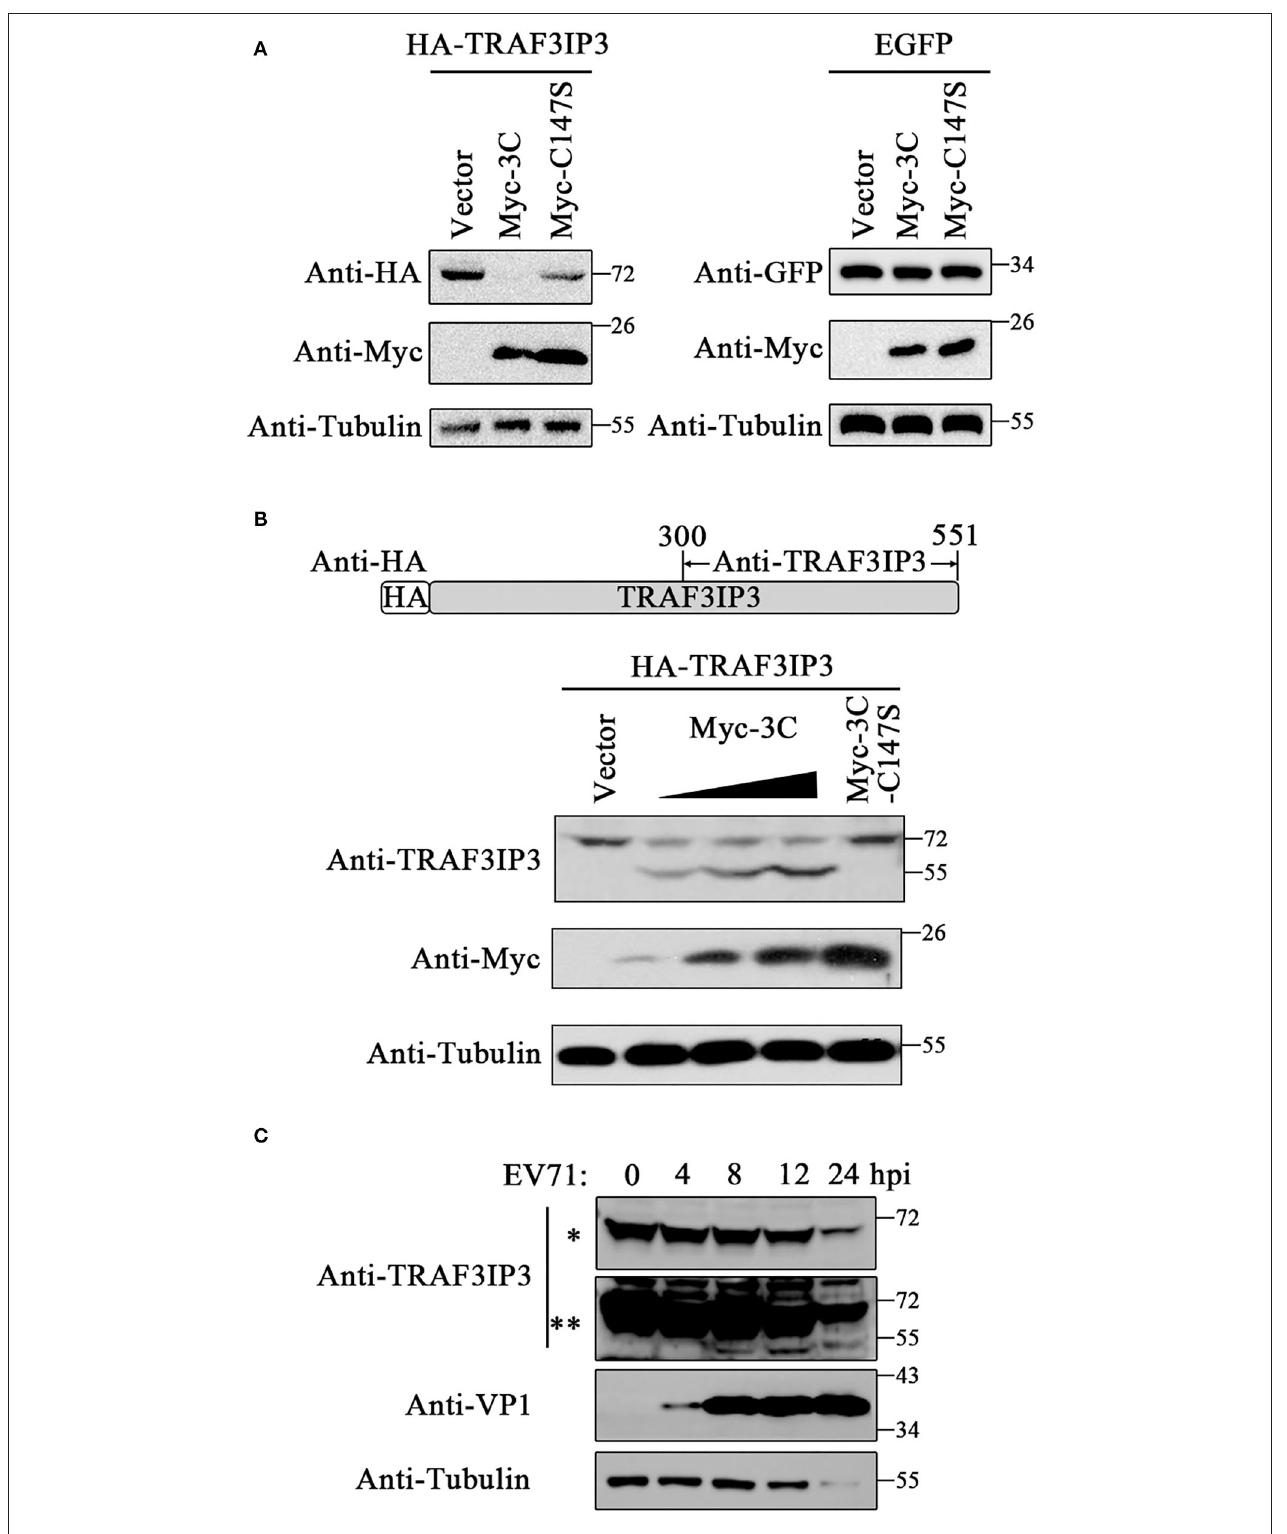
FIGURE 2 | TRAF3IP3 is the cleavage substrate for 3C pro . (A) HA-TRAF3IP3 or GFP was co-transfected with 3C pro or C147S into HEK293T cells. Cells were harvested 48h later for Western blotting. (B) HEK293T was co-transfected with HA-TRAF3IP3 and a gradient of Myc-3C, with C147S as a non-cleavable control. The cleavage bands were detected using the antibody recognizing the C-terminus of TRAF3IP3. (C) EV71 at an MOI of 10 was used to infect into Jurkat cells for 0, 4, 8, 12, and 24h, and the cleavage of endogenous TRAF3IP3 was detected using Western blotting. * and ** represent short and long exposures, respectively.